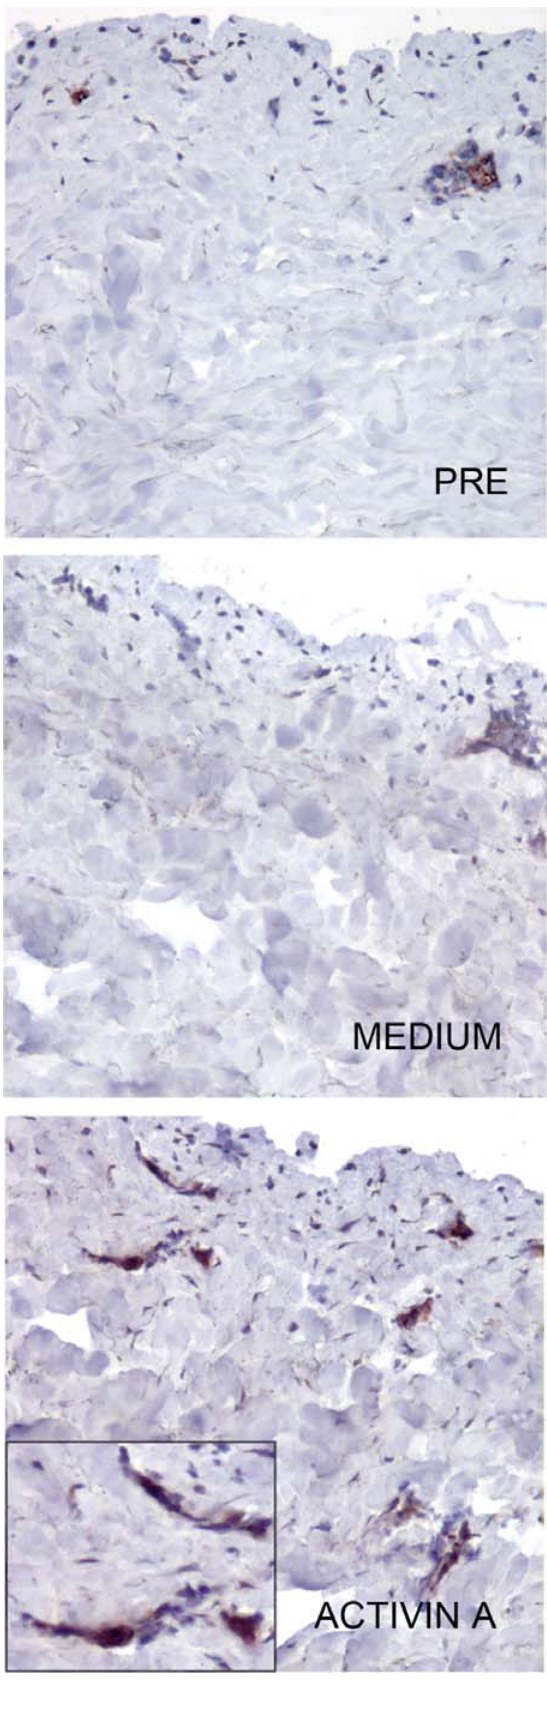
Figure 4. Activin A induces Langerhans cells differentiation in epidermis-depleted skin explants. Langerin expression was eval- uated in the dermal layer, separated from skin explants by dispase digestion and subsequently treated for 72 hrs after i.d. injection